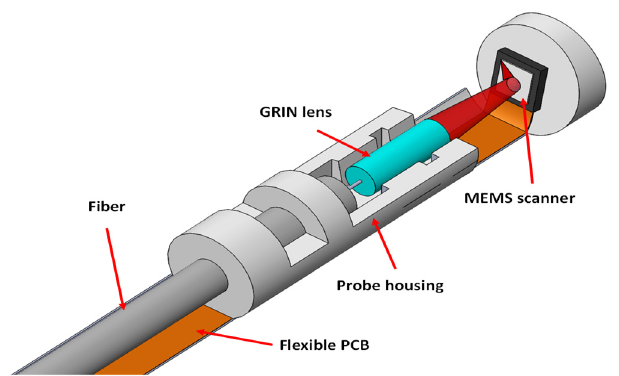
Figure 8. Schematic of a compact optical coherence tomography (OCT) probe (diameter: 2.8mm) with thermoelectric-actuated scanner, hidden actuators, a graded-index (GRIN) lens, a flexible printed circuit board (PCB) and a probe housing made from a fluorinated ethylene [47].